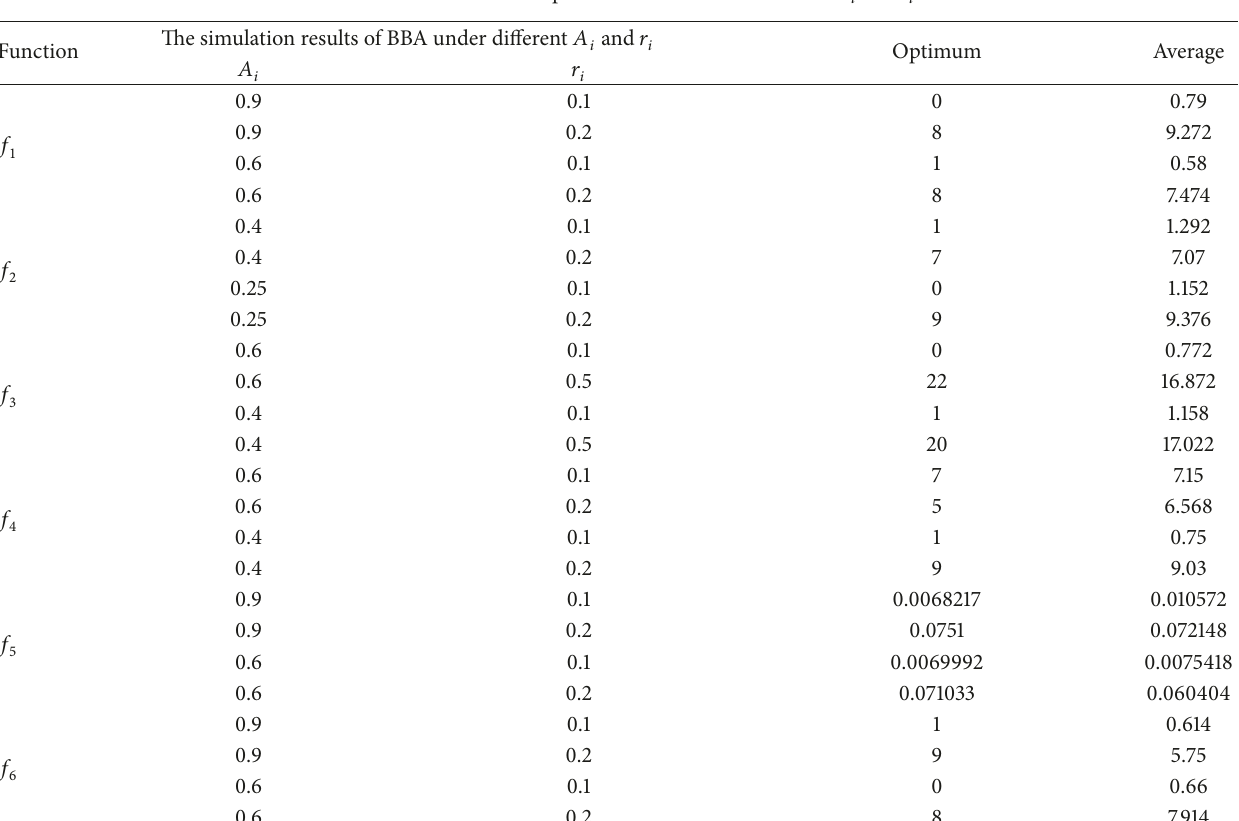
Table 4: Performance comparison of BBA under different 𝐴 𝑖 and 𝑟 𝑖